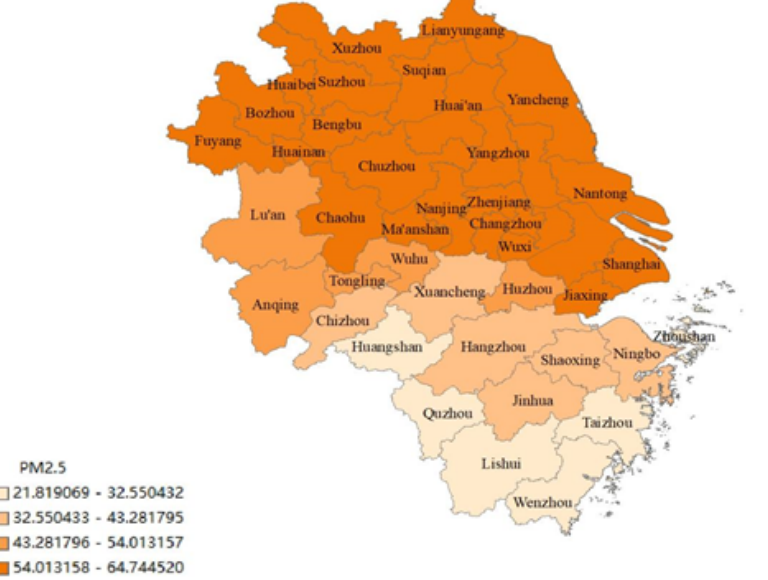
Figure 1. The spatial–distribution of haze pollution in Yangtze River Delta in